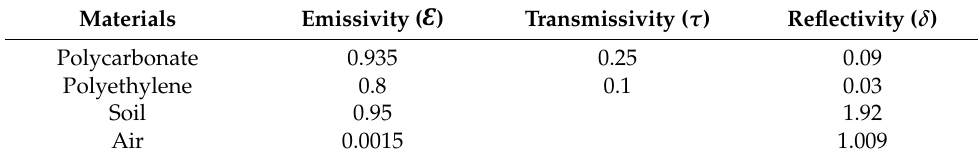
Table 2. Optical properties of materials to thermal radiation.